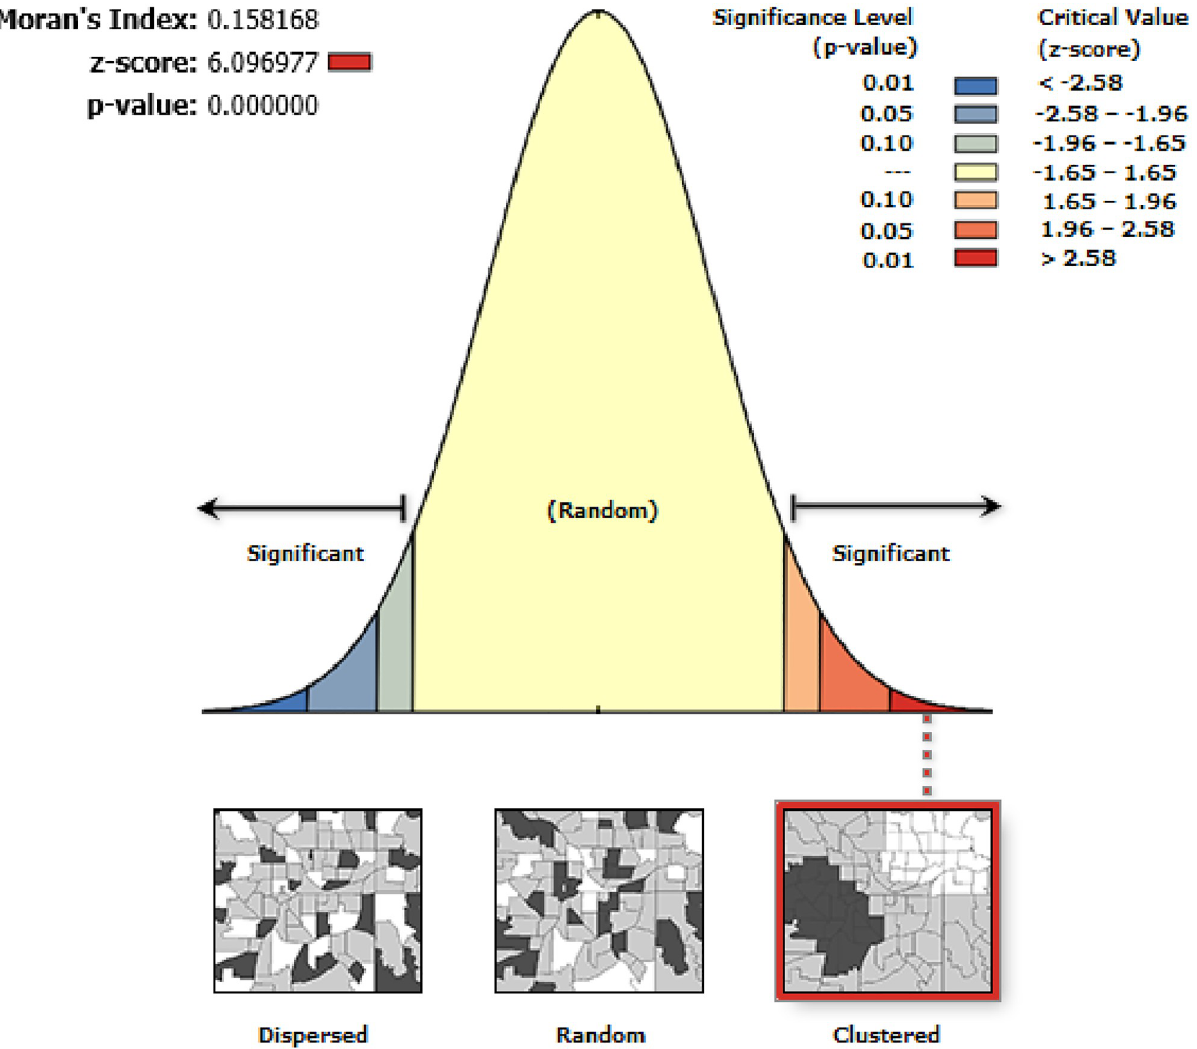
Fig 3. The global spatial autocorrelation analysis delayed initiation of breastfeeding in